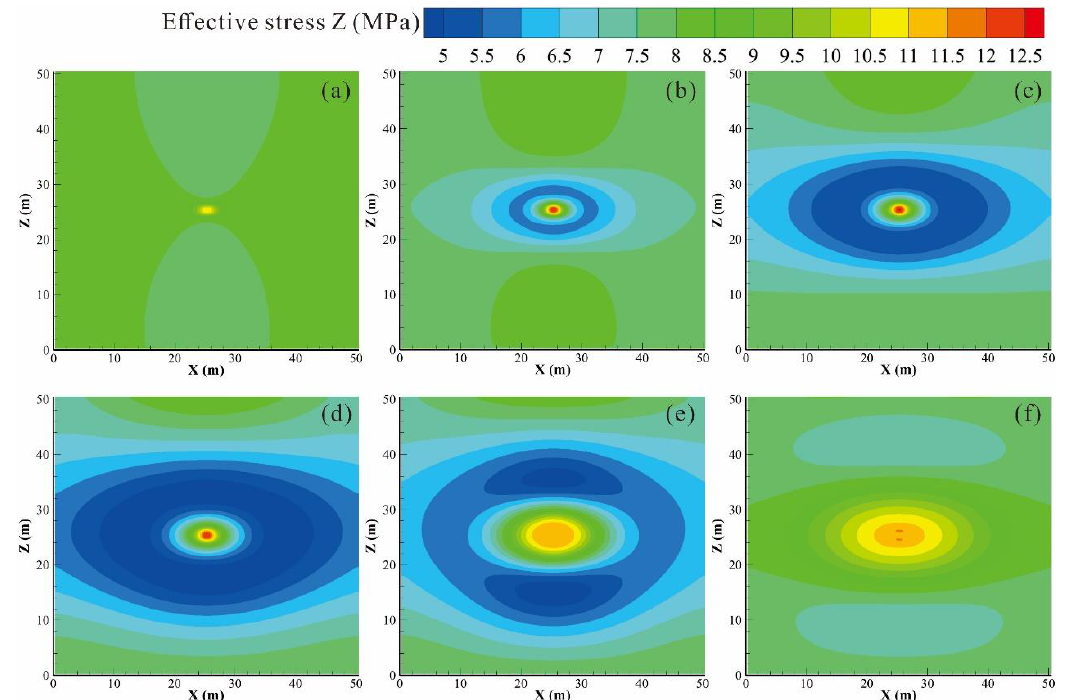
Figure 16. Spatial distributions of model predicted effective stress in Z direction at ( a ) 496.5 days, ( b ) 938.5 days, ( c ) 1668.5 days, ( d ) 2763.5 days, ( e ) 3128.5 days, and ( f ) 4588.5 days.